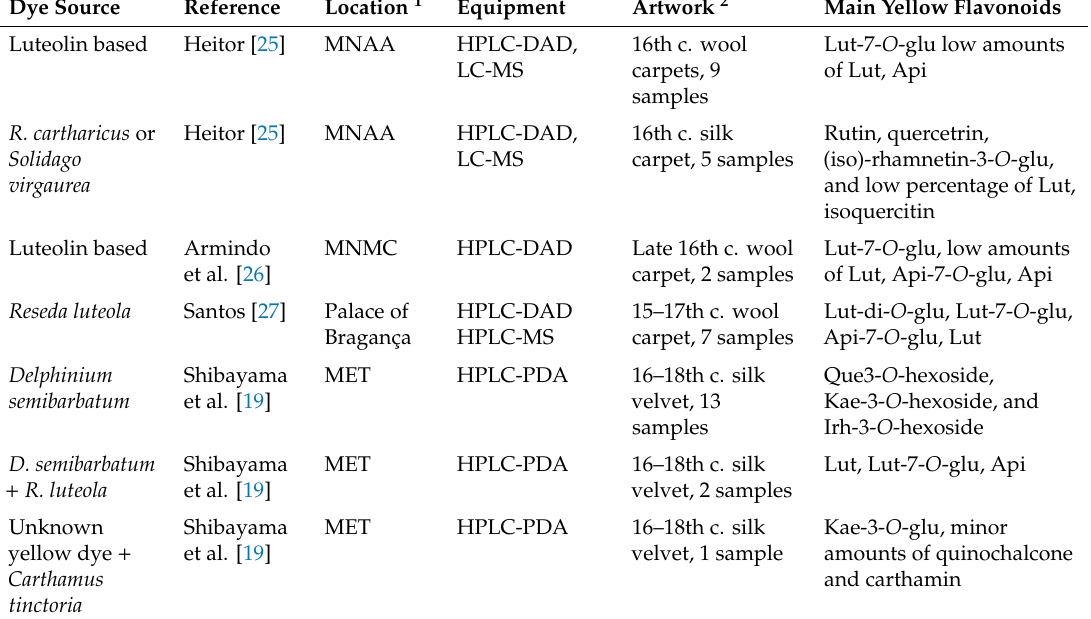
Table 2. Yellow flavonoids identified in Persian textiles, analytical methods used in their identification, and number of samples